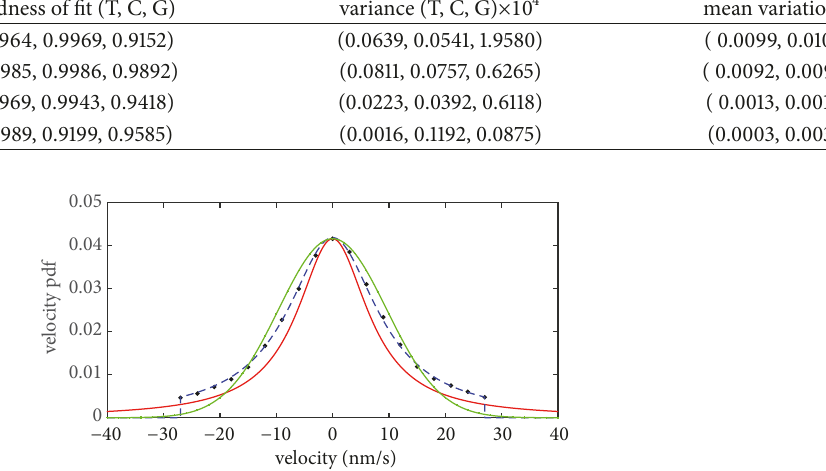
Figure 5: Velocity PDF: the solid line (red) represents the Cauchy-Lorentz distribution, the dashed line (blue) is the truncated Cauchy- Lorentz distribution, the “+” line (green) is the Gaussian distribution, and the black dots are the experimental data, when I=0.1 (tunneling current) and V=10 (bias